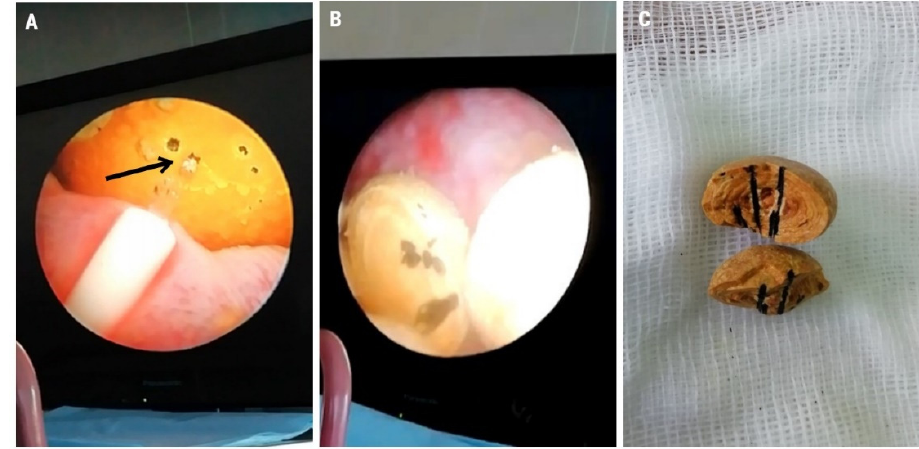
Figure 4. Controlled stone fragmentation in the operating room, stones in the bladder cavity ( A – C ): ( A ) the tip of the fiber (indicated by the arrow) is removed from the ureteral catheter (used as a casing) and brought to the stone; ( B ) one of the stones is fragmented into two fragments; ( C ) parts of the stone after extraction on the experimental table.